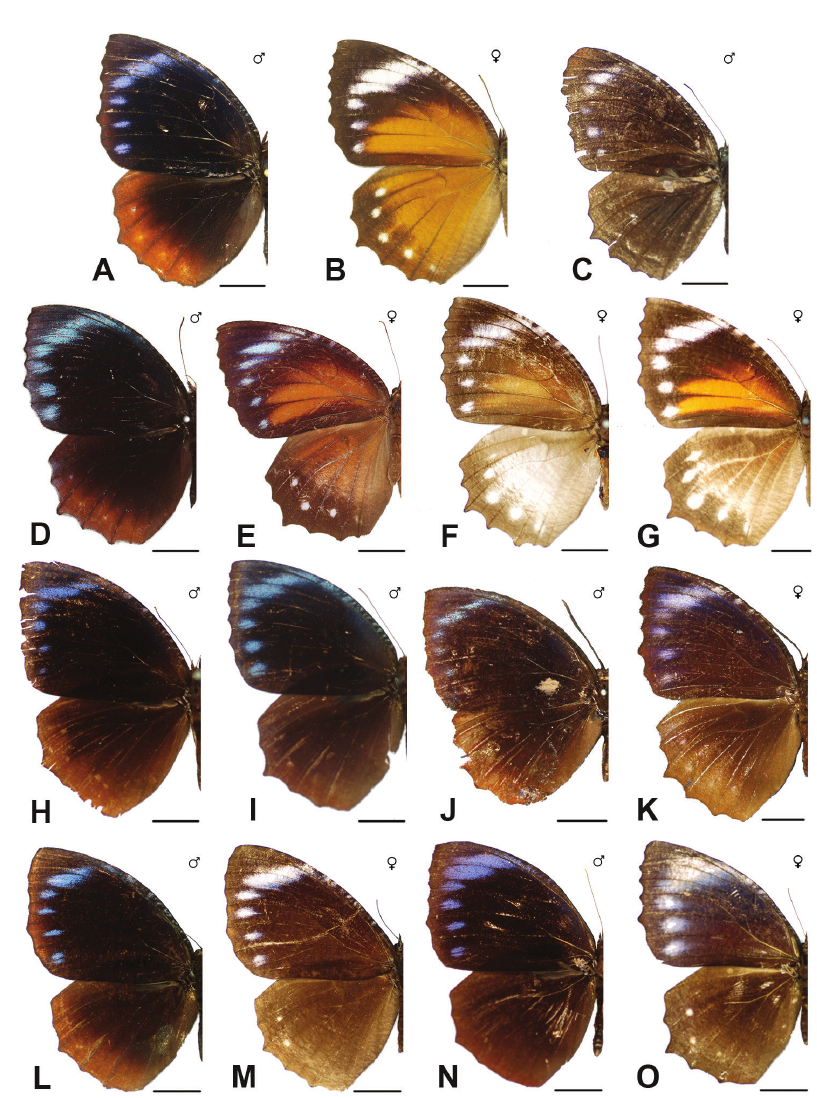
Figure 7. A hypermnestra baliensis ♂ D NHM Indonesia: Bali B hypernmestra baliensis ♀ D NHM Indonesia: Bali C hypermnestra baliensis ♂ D NHM Indonesia: Bali; Holotype of Elymnias nigrescens bulelenga D hypermnestra tinctoria ♂ D KUTH Thailand: Chiang Mai E hypermnestra tinctoria ♀ D KUTH Thailand: Chanthaburi F hypermnestra violetta ♀ D NHM Thailand: Sri Racha; Holotype